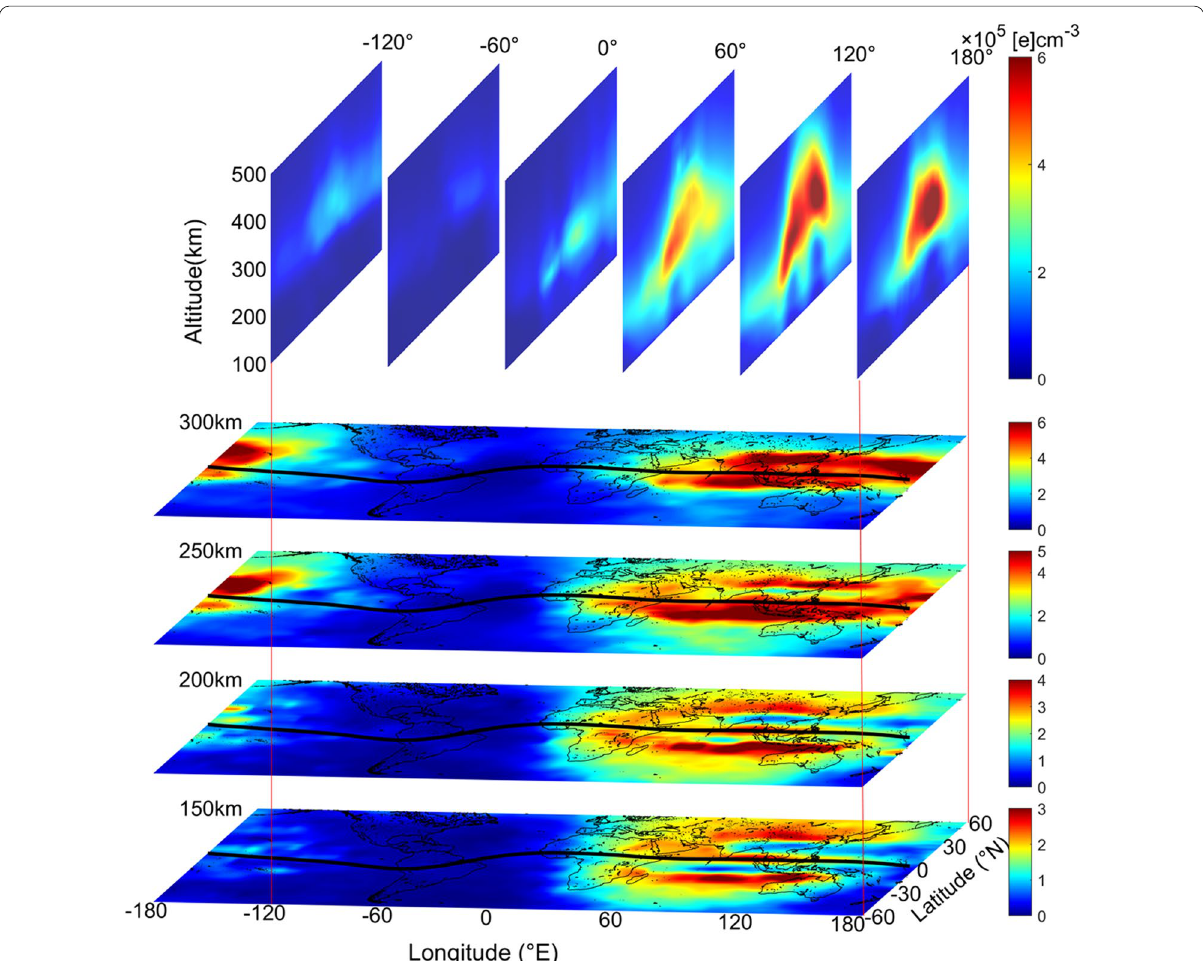
Fig. 1 The 3D F3/C electron density structure at 0600 UT during May–July 2009. The horizontal maps reveal well developed EIA bands, being pronounced around 250–300 km altitudes over 60–180°E longitudes. The plasma caves appear at below 250 km in 90°E and 120°E longitude slices in the top panel. All the observations during the two months are arranged in two‑hour bins centered at the time selected, and median values within a 2.5° 2.5° longitude‑latitude, and 5 km altitude grid are ×